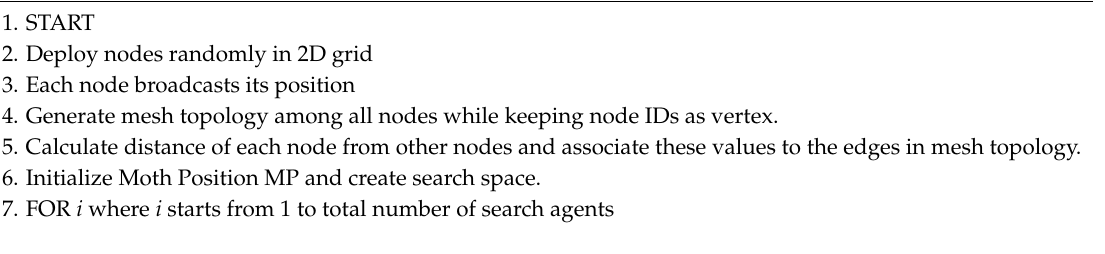
Algorithm 1 : Smart Ocean Under Water Sensor Network